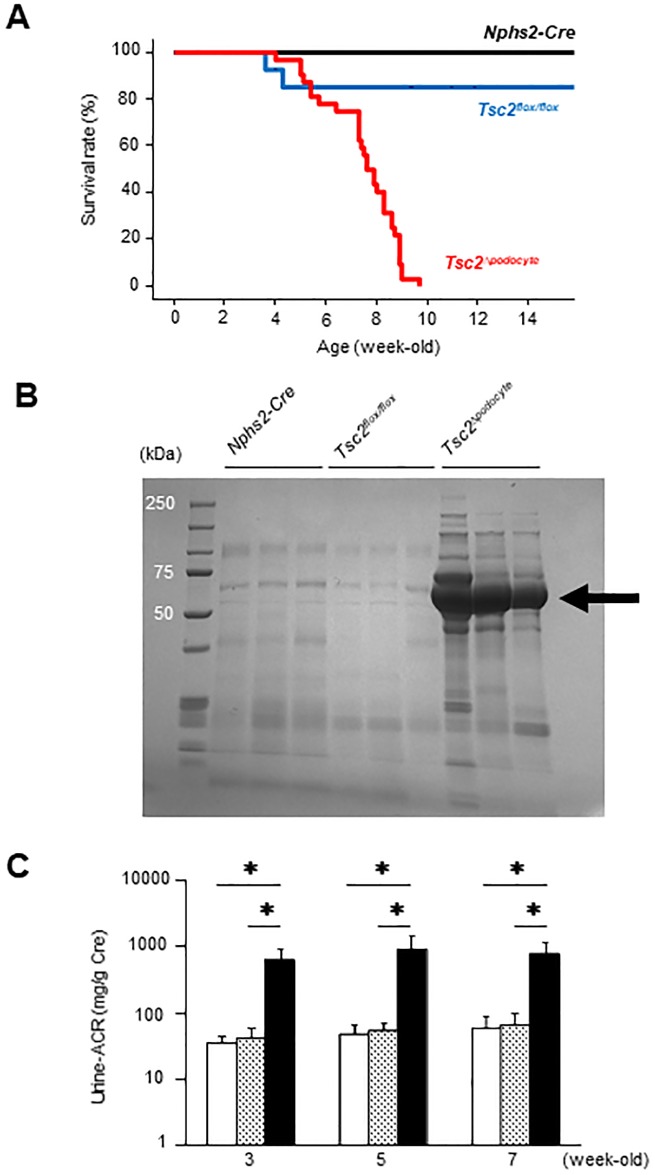
mTORC1 activation in podocytes causes proteinuria and increased mortality.(A) Kaplan-Meier survival plots for Tsc2Δpodocyte and control mice. A significant increase in mortality was found in Tsc2Δpodocyte compared with control mice. Nphs2-Cre (black line), n = 9; Tsc2flox/flox (blue line), n = 10; Tsc2Δpodocyte (red line), n = 32. (B) At 3 weeks, Tsc2Δpodocyte became albuminuric. SDS-PAGE gel shows a microliter of urine was loaded for each lane. (C) Seven-week follow-up of Tsc2Δpodocyte for proteinuria (n = 10 per group). Results are expressed as means ± s.d. White bar, Nphs2-Cre; dotted bar, Tsc2flox/flox; black bar, Tsc2Δpodocyte. Results are expressed as means ± s.d. *P < 0.05 compared with age-matched controls.